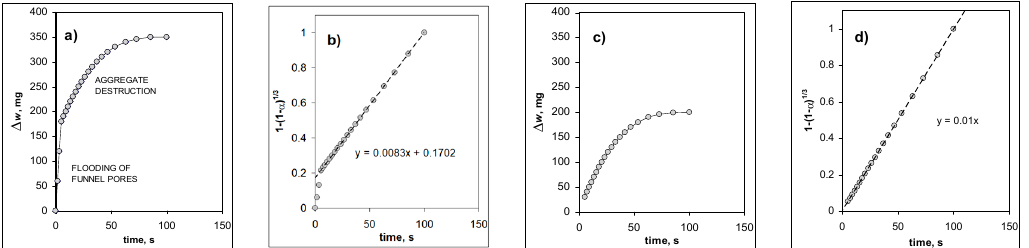
Figure 2. ( a ) Simulated destruction curve including initial flooding of funnel pores and aggregate destruction from Figure 1a. ( b ) The plot of the above curve in coordinates of Equation (4). ( c ) The curve ( a ) after subtraction of the amount of air released from funnel pores ( FP ) from Equation (4), and ( d ) the plot of the curve ( c ) in coordinates of Equation (4).